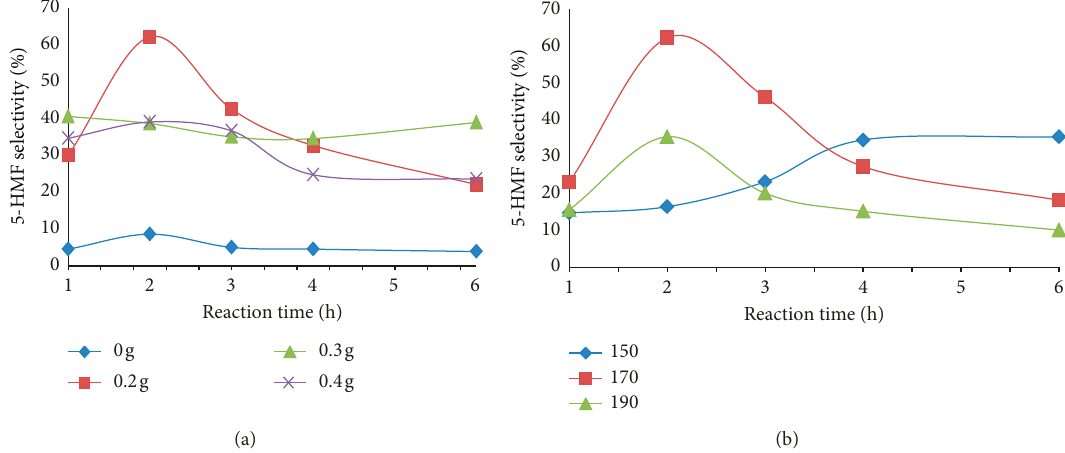
Figure 7: Effect of catalyst dosage (a) and reaction temperature (b) on the catalytic conversion of